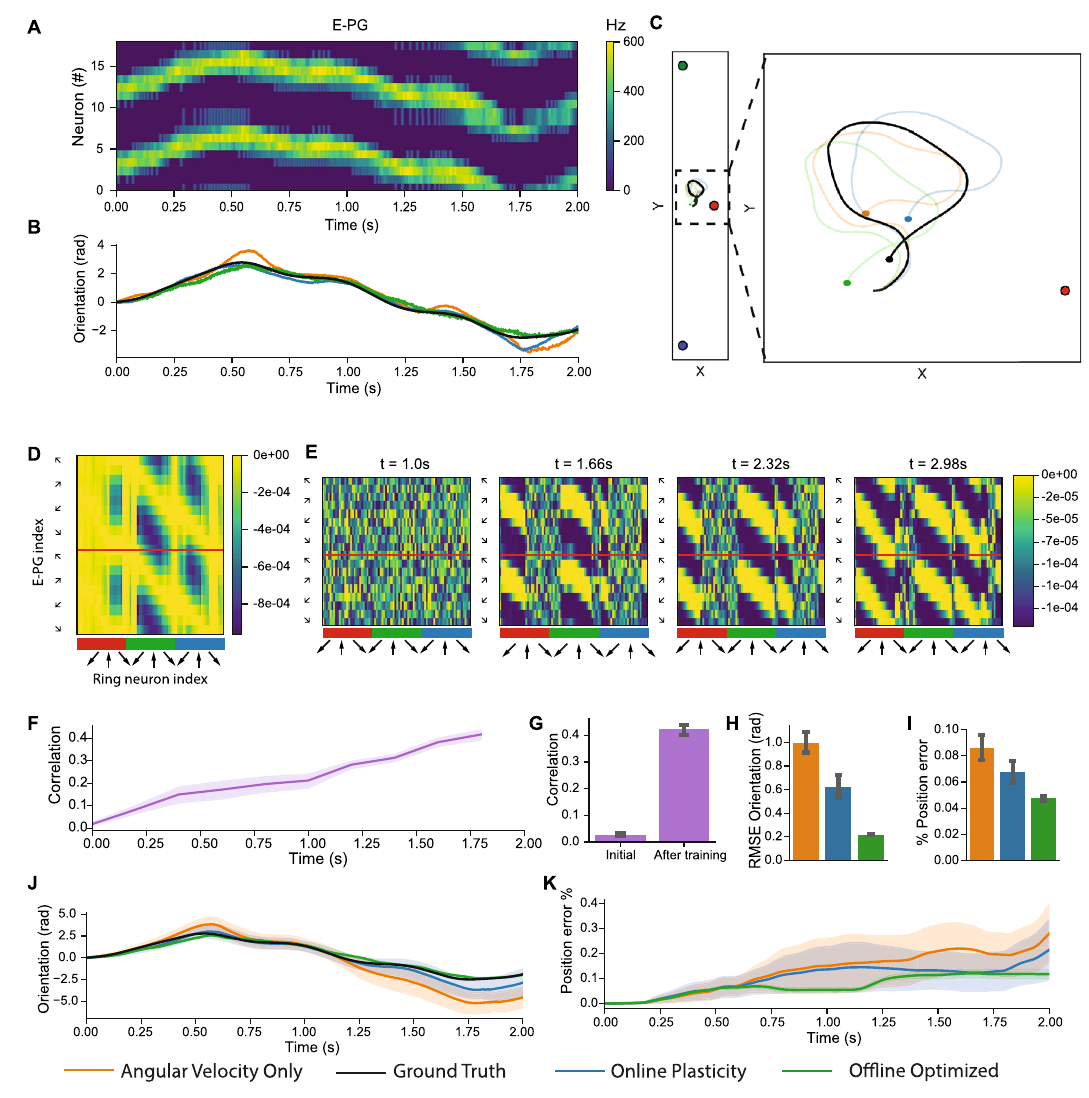
Figure 3. Sensor fusion and online learning with translation in simulation. ( A ) Shifting of the activity bump in E-PG neurons in the online learning model corresponds to changes in orientation. ( B ) The decoded orientation estimation (best seed) with model configurations tracks the ground truth trajectory. ( C ) Two distant landmarks and one close landmark provide visual inputs to the network. Position estimates with path integration r → c approximate ground truth (final positions denoted with a circle). ( D ) Offline optimized W has features preferentially tuned to distant landmarks. ( E ) Evolution of weights during online plasticity share structure with offline optimized weights. ( F–G ) Correlation between online learned weights and the offline optimized solution increases over time. ( H ) Average orientation RMSE with online plasticity is less than angular velocity alone model configuration. ( I ) Improvement in position error (average position error as a percentage of path length) additionally observed with online plasticity versus angular velocity alone. In orientation estimates ( J ) and position error as a fraction of path length ( K ), error accumulates less with online plasticity than angular velocity alone. Group level analyses in ( F – K ) are performed for 50 simulated seeds. ( F – I ) have 95% bootstrapped confidence intervals, ( J – K ) have standard deviation confidence